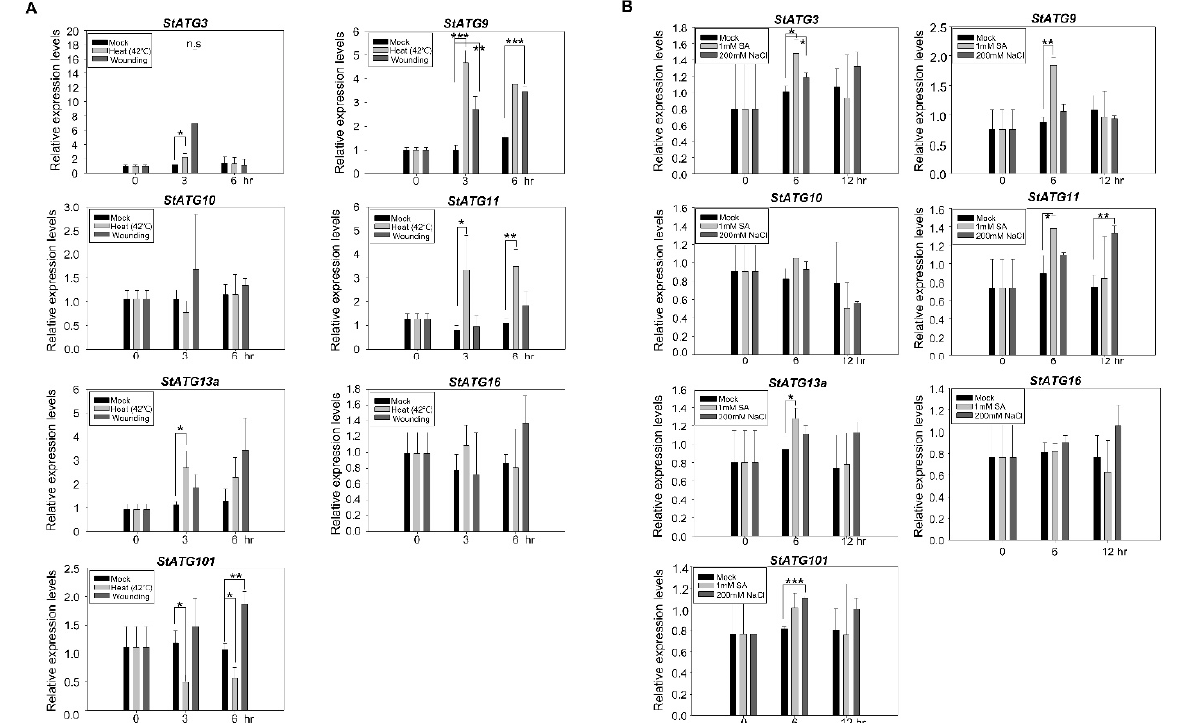
Figure 5. Core StATG genes responded to multiple stresses. ( A , B ). Real-time PCR analysis of core StATG genes in response to heat (42 °C), mechanical wounding ( A ), 1 mM salicylic acid (SA), and 200 mM NaCl treatments ( B ). For stress treatments, 4-week-old potato plants were used for stress treatment for the indicated times. StEF1 α was used as a reference gene. Error bars indicate the standard deviations of three independent qRT-PCR biological replicates. Error bars represent SD of three independent experiments. Asterisks indicate significant differences from the control using the unpaired Student’s t -test (* p < 0.05, ** p < 0.01, and *** p < 0.001).